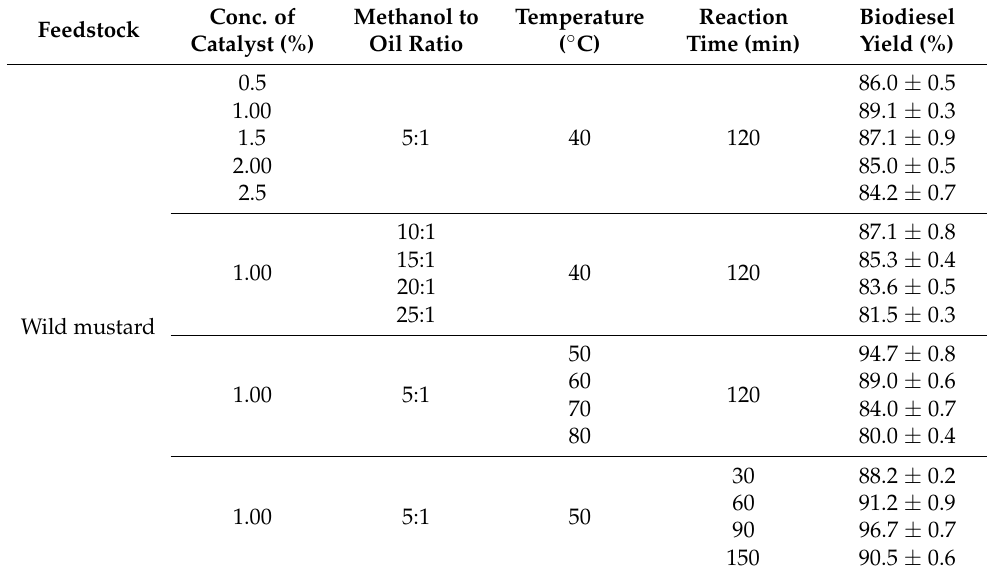
Table 4. Yield of biodiesel from wild mustard oil with changes in reaction parameters. Conc. of Methanol to Temperature Reaction Feedstock Catalyst (%) Oil Ratio ( ◦ C) Time (min)